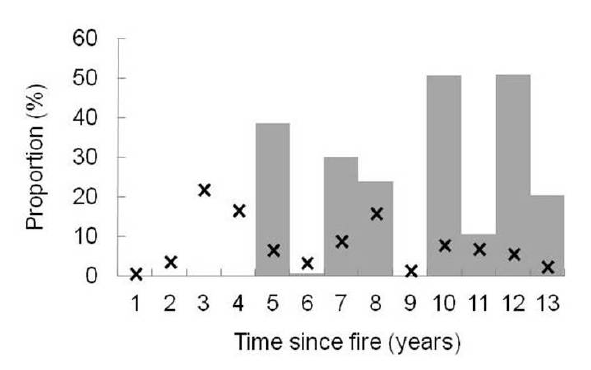
Fig. 9 . Fire incidence in relation to age class for the two transects that were sampled both in 2007 and in 2008. Bars denote the proportion of the area in each age class that was burned between January 2007 and February 2008. x denotes the “available” area in each age class at the beginning of the dry season